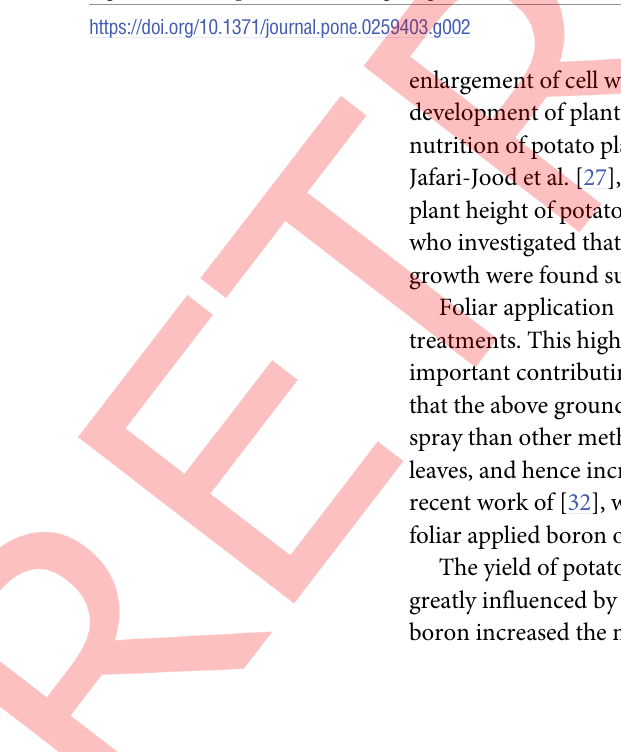
Fig 2. Relationship of vitamin C (mg 100g -1 ) and B concentration in potato